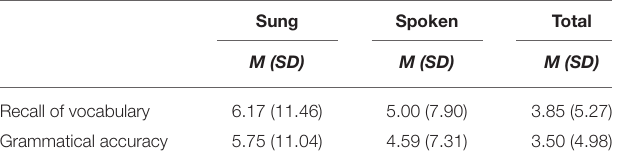
= 0.42]. It thus appears that F (2, 31) = 11.21, p < 0.0001, n 2 p